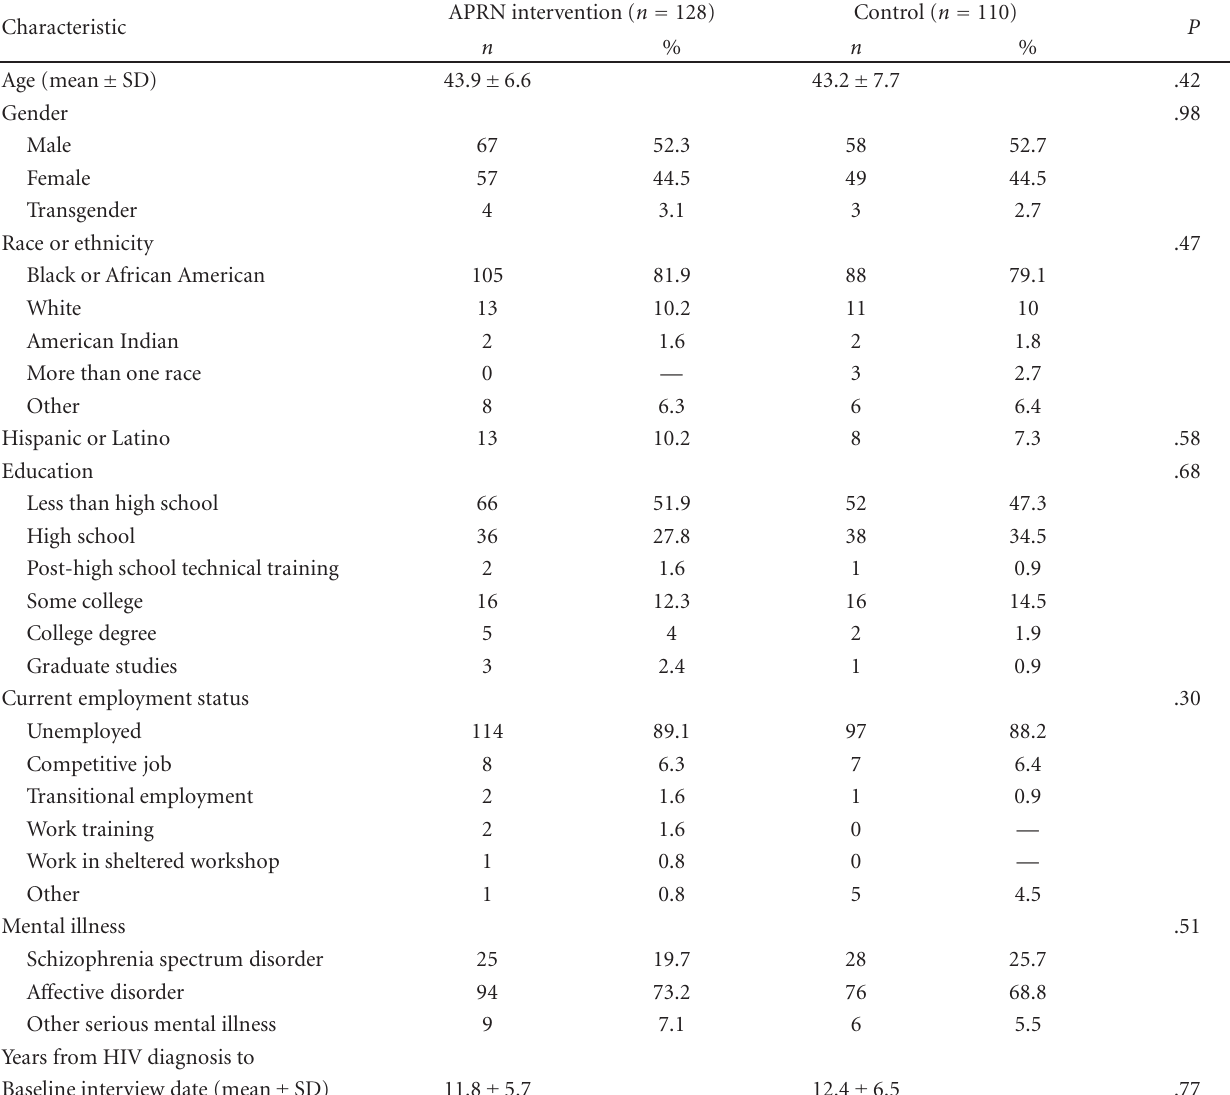
Table 1: Baseline characteristics of sample receiving an intervention from an advanced practice psychiatric nurse or usual care.